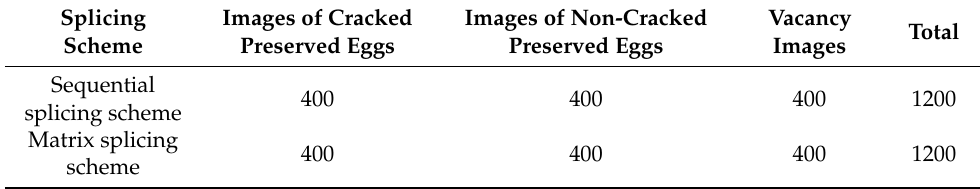
Table 1. Online inspection data